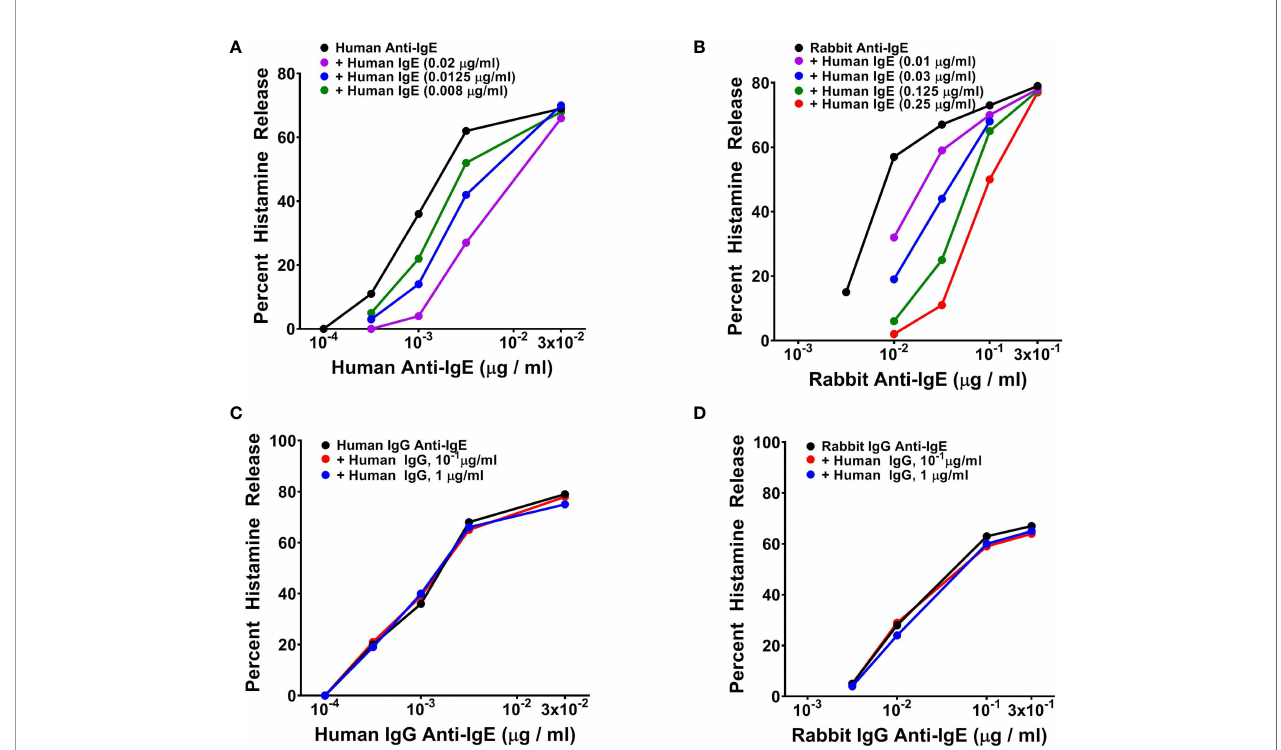
FIGURE 3 | (A) Effects of increasing concentrations of human monoclonal IgE on human IgG anti-IgE-induced HR from human basophils. Cells were preincubated (10 minutes, 37°C) with the indicated concentrations of IgE and then challenged with the indicated concentrations of human IgG anti-IgE for an additional 30 minutes at 37°C. Each value is the mean of duplicate determinations in a typical experiment out of three similar experiments. (B) Effects of increasing concentrations of human monoclonal IgE on rabbit IgG anti-IgE-induced HR from human basophils. Cells were preincubated (10 minutes, 37°C) with increasing concentrations of IgE and then challenged with the indicated concentrations of rabbit IgG anti-IgE for an additional 30 minutes at 37°C. Each value is the mean of duplicate determinations in a typical experiment out of four. (C) Effect of increasing concentrations of human polyclonal IgG puri fi ed from a healthy donor on human IgG anti-IgE-induced HR from human basophils. Cells were preincubated (10 minutes, 37°C) with increasing concentrations of human polyclonal IgG and then challenged with the indicated concentrations of human IgG anti-IgE for an additional 30 minutes at 37°C. (D) Effect of increasing concentrations of human polyclonal IgG puri fi ed from a healthy donor on rabbit IgG anti-IgE-induced HR from human basophils. Cells were preincubated (10 minutes, 37°C) with increasing concentrations of human polyclonal IgG and then challenged with the indicated concentrations of rabbit IgG anti-IgE for an additional 30 minutes at 37°C. Each value is the mean of duplicate determinations in a typical experiment out offour.